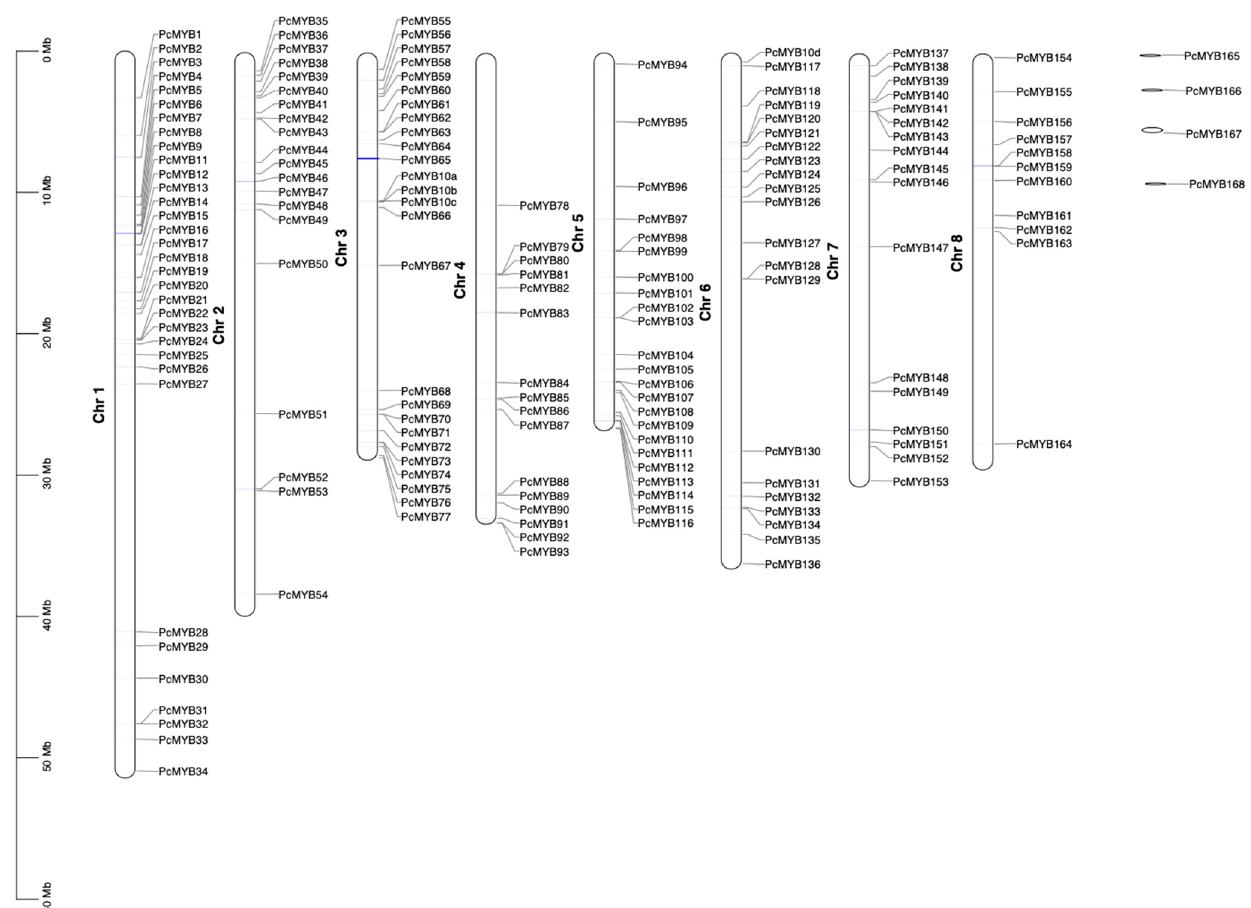
Figure 6. Chromosomal localizations of the MYB genes. The bars represent the P. campanulata chromosomes. The scale bar on the left indicates the physical distance of the MYB genes on the chromosomes. Four MYB genes on the right are located on the scattered scaffolds.